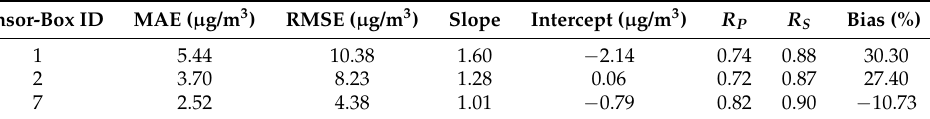
Table 6. Results of statistical analysis of stationary senor-box measurements in Stans, Nidwalden. Measurements recorded between 15 October 2021 and 31 December 2021. Fixed percentile filtering method (99.0%) is applied to the raw data. No further calibration applied.